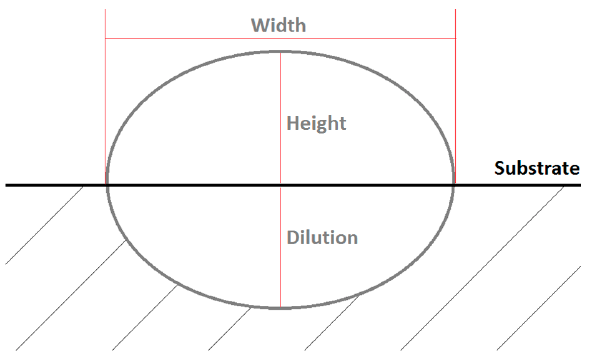
Figure 4. Sketch of the measured dimensions of clads.